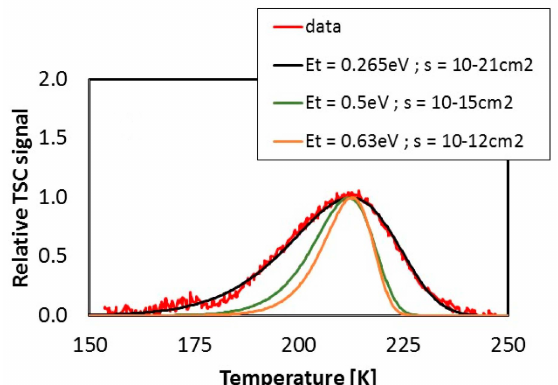
Figure 8. Relative TSC signal extracted from data for a single TSC component is fitted using Equation (8) with di ff erent couples ( E t , σ ). The relative TSC signal is obtained by subtracting from the TSC curve shown in Figure 7b all the other TSC components but the one attributed to the peak at 210 K, in view to study a single TSC